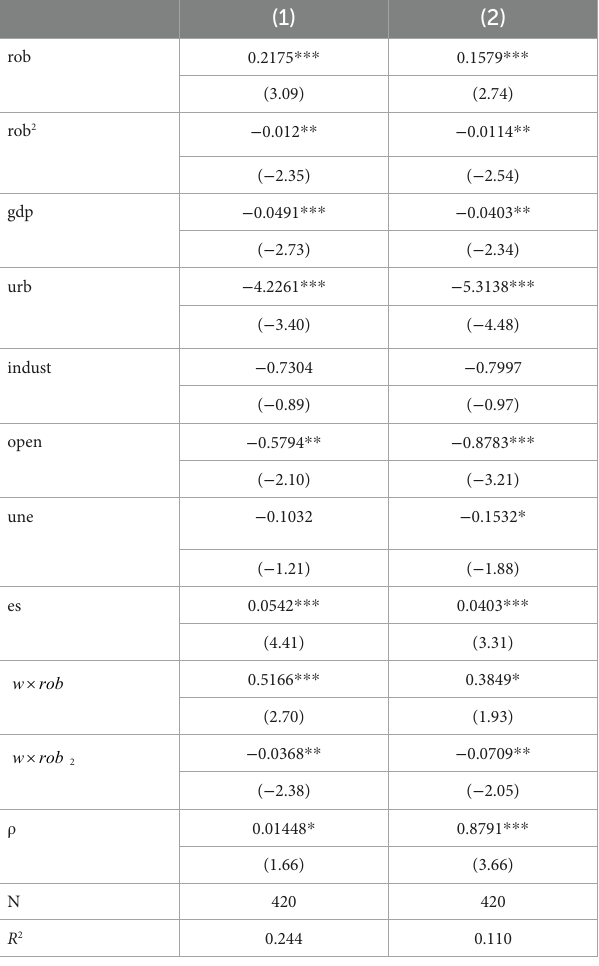
TABLE 4 Regression of spatial Durbin